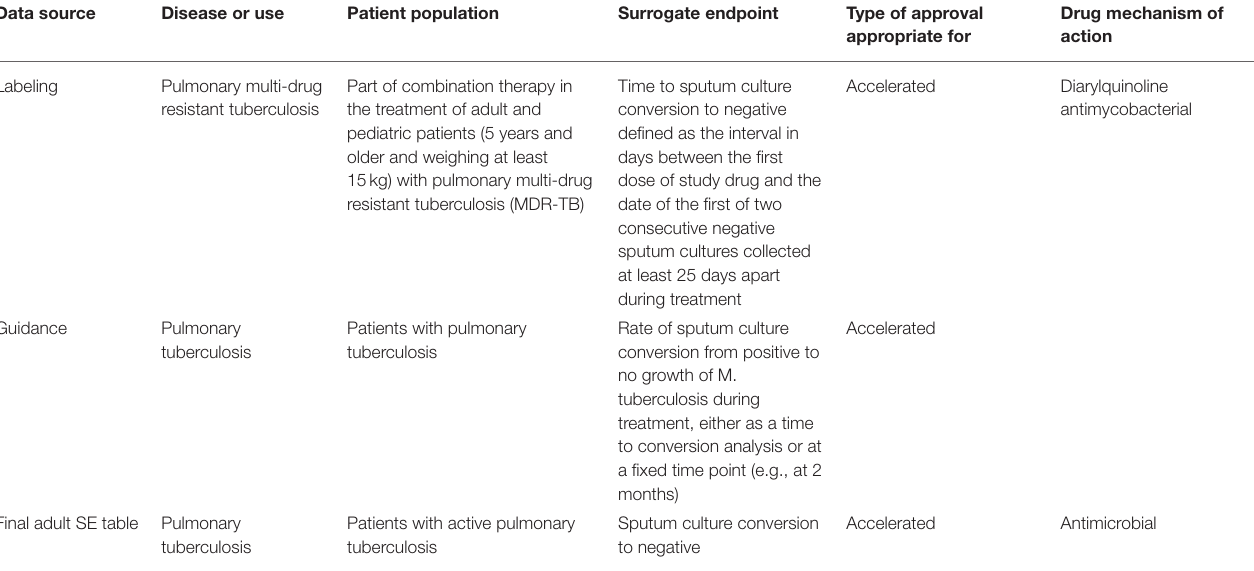
TABLE 1 | An example of how the descriptions for the SE table were adapted from various data sources [drug label for SIRTURO® (bedaquiline) (8) and the guidance (12)] can be found for pulmonary tuberculosis. Data